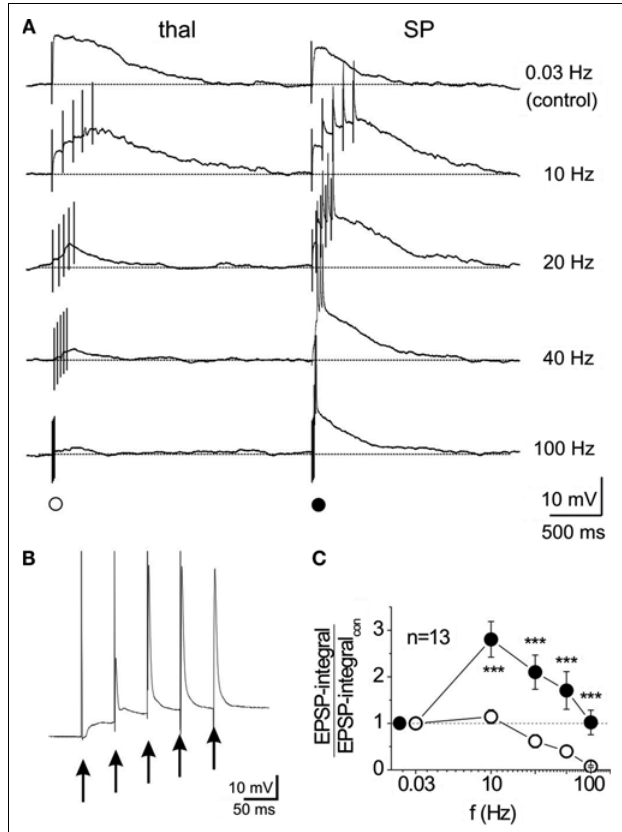
FIGURE 4 | Input-specifi c differences in temporal summation of NMDA receptor-mediated EPSPs recorded in subplate neurons of the newborn mouse cerebral cortex. Recordings were performed in the presence of CNQX and bicuculline methiodide to isolate NMDA receptor-mediated EPSPs. (A) Five successive stimuli to the thalamic (left) or subplate (right) input reveals prominent temporal summation and repetitive action potentials (truncated) of the subplate input at frequencies between 10 and 40 Hz. All recordings were obtained at a membrane potential of − 80 mV. (B) Synaptic response to 20-Hz subplate stimulation at higher resolution [same trace as in (A) ]. (C) Quotient between NMDA receptor-EPSP integral and control integral (determined at 0.03 Hz) for 13 subplate neurons. Reproduced with permission from Hirsch and Luhmann